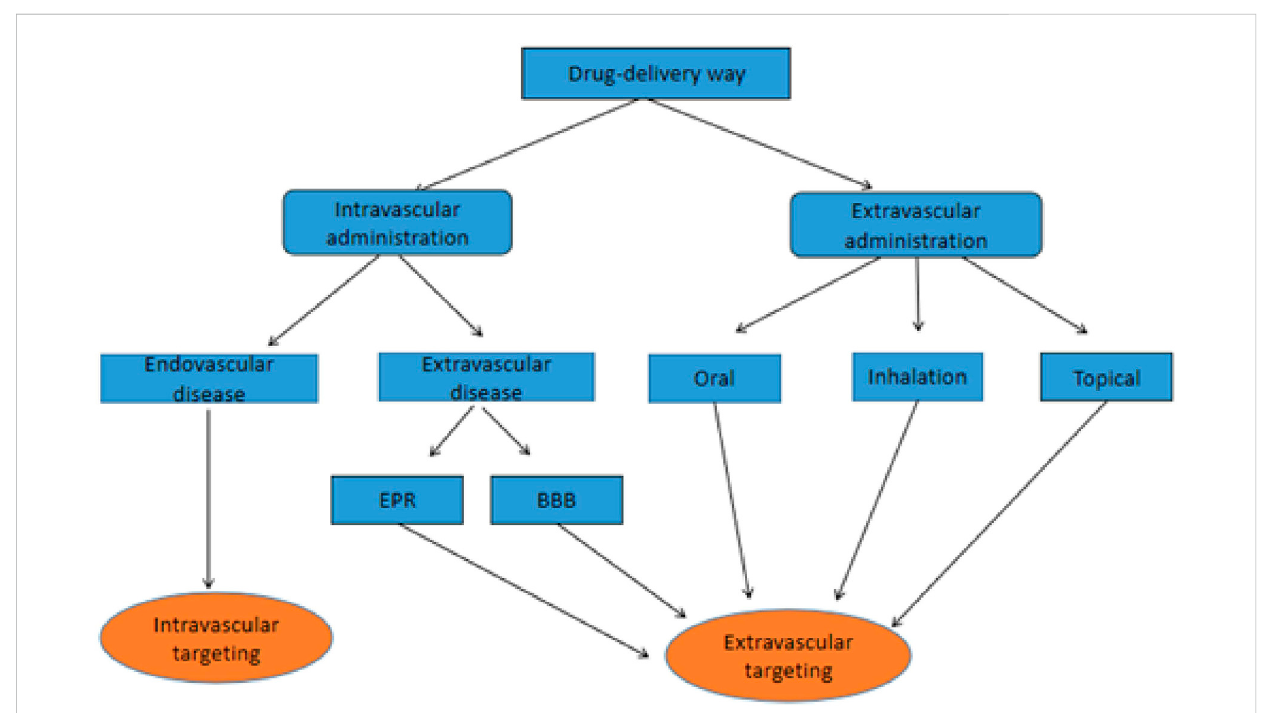
FIGURE 1 Flowchart of different routes of administration and endovascular targeting vs. extravascular